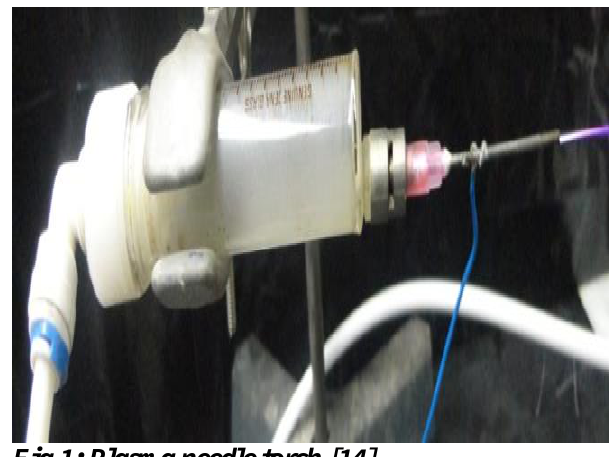
Fig.1: Plasma needle torch [14] 2. Bacterial Sample